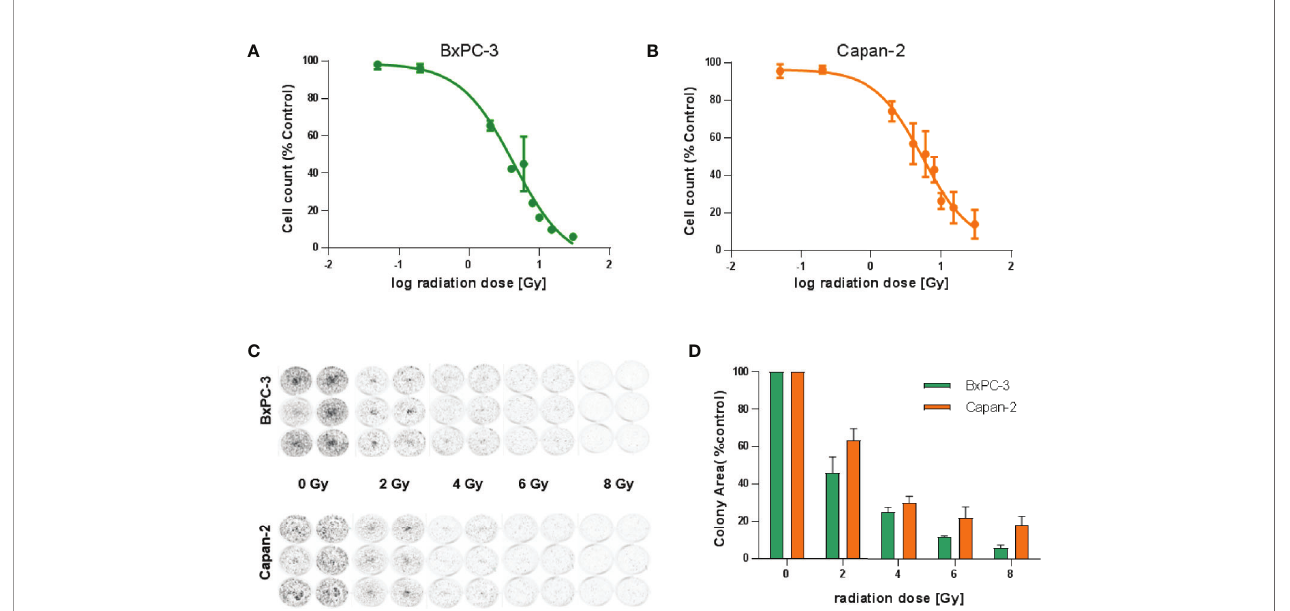
FIGURE 2 | Radiosensitivity of BxPC-3 and Capan-2 cells. (A) BxPC-3 and Capan-2 (B) cells were exposed to different doses of radiation (0, 0.05, 0.2, 2, 4, 6, 8, 10, 15 and 30 Gy). 96 hours later, nuclei were stained and counted. (C, D) BxPC-3 and Capan-2 cells were irradiated with 0, 2, 4, 6 or 8 Gy. Cells were incubated for 1 week. Colonies were stained and colony area was measured. Data represent mean ± S.E.M. (n = 5).